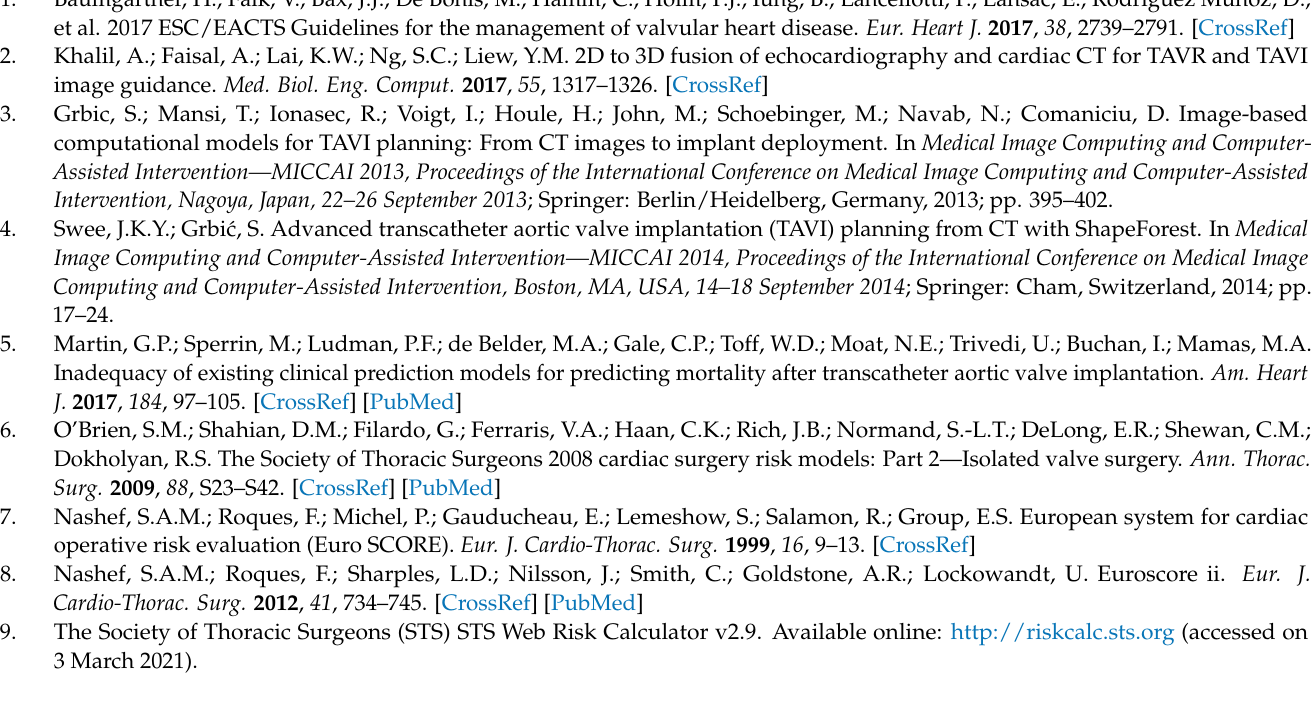
Figure A2. Normalized bar plots with distributions of the categorical features of the two different centers. Non-survived and survived patient distributions are shown in orange and blue, respectively. For all features, missing values are reported in grey, numerical values are identified with pure orange and pure blue, while categorical instances are represented with graduated levels of orange and blue.